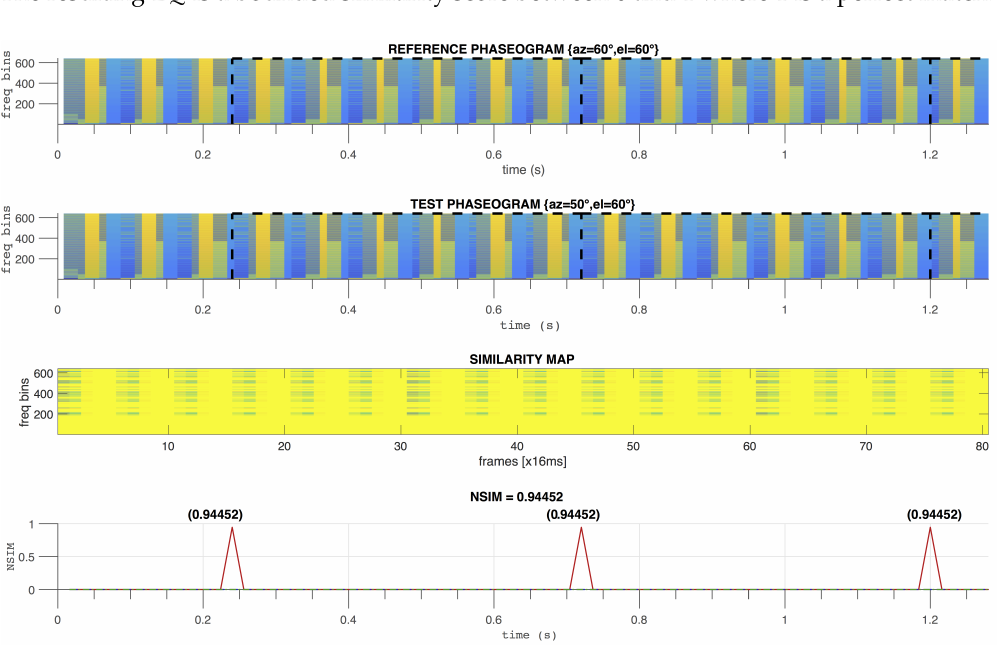
Figure 7. Phaseograms, similarity map, and similarity scores for 100 Hz pure sine wave signals. The Reference signal is localized at Azimuth = 60 ◦ , Elevation = 60 ◦ , the Test signal at Azimuth = 50 ◦ , Elevation = 60 ◦ and resulting localization accuracy score is 0.944.